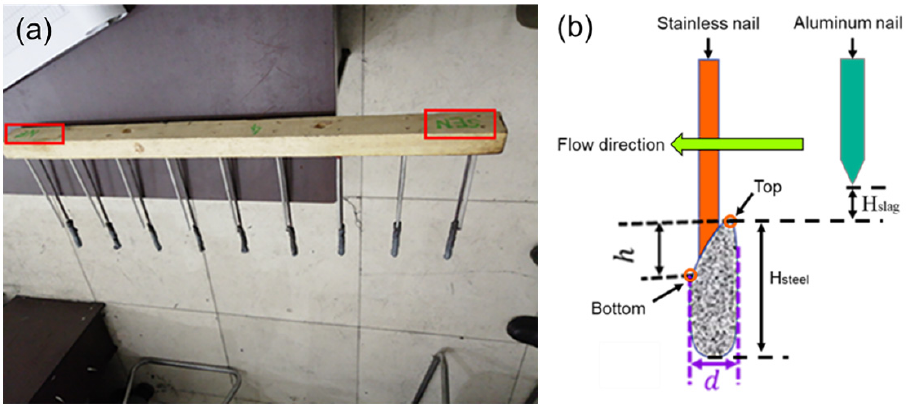
Figure 18. Dipping tests. ( a ) Morphology of nails after dipping tests and ( b ) characteristic parameters of solidified steel lumps.